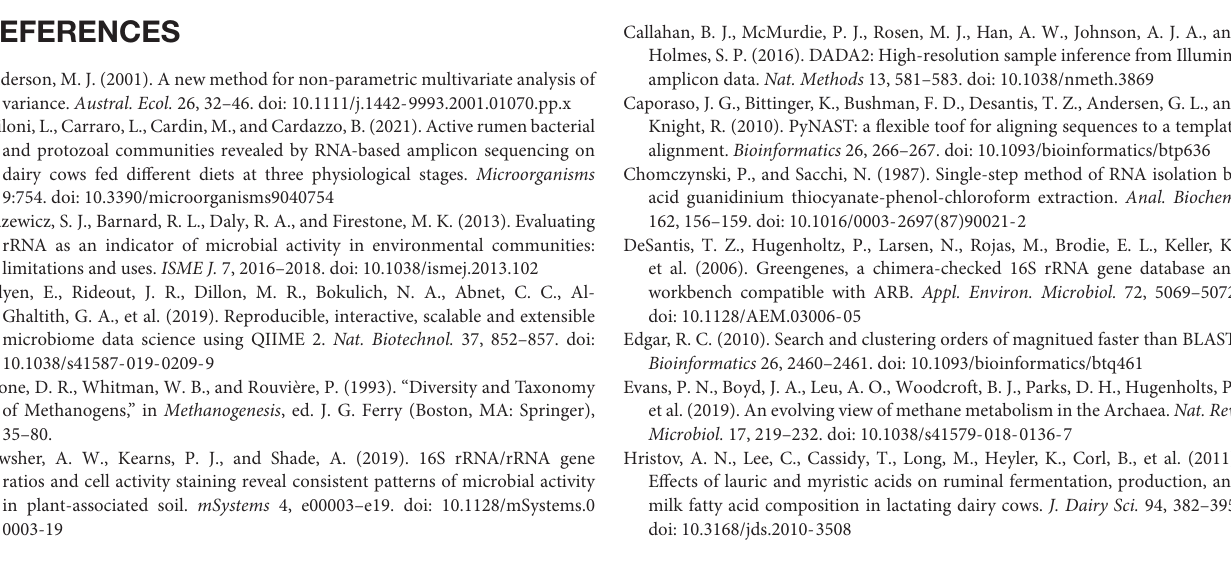
(B) tube solid (TS) samples. Microbial taxa were considered present in a sample if their sequence proportion was at least 0.01% of relative abundance. Correlation is shown by the color code (blue: positive correlation, red: negative correlation). Supplementary Table 1 | Absolute abundance of bacterial ASV (A) and archaeal OTU (B) by sample type [tube solid (TS) and cannula solid (CS)] in total (DNA) and potentially metabolically active (cDNA) communities. Supplementary Table 2 | P values denoting level of significance for community patterns revealed by principal coordinate analysis estimates by sample type. Non-parametric permutational multivariate ANOVA test was used to test differences by sampling type. Supplementary Table 3 | Mean relative abundance (%) of bacterial and archaeal taxa (identified to the genus level) by sample type [tube solid (TS) and cannula solid (CS)] in total (DNA) and potentially metabolically active (cDNA) communities. Supplementary Table 4 | Kruskal–Wallis Rank Sum Test analysis for the observed species and Shannon diversity, for Supplementary Figures 1 , 2 . Supplementary Table 5 | Differences in mean abundance of microbial taxa between total (DNA) and potentially metabolically active (cDNA) components. Significant differences in microbe composition between DNA and cDNA detected by ANCOM at a P value threshold of 0.05. Supplementary Table 6 | Concentration of volatile fatty acids (VFA) in tube solid (TS) and cannula solid (CS) samples. Supplementary Table 7A | Amplicon sequence variants (ASV) significantly associated with volatile fatty acids (VFA) in tube solid (TS) and cannula solid (CS) samples. The correlation coefficients (r) greater than 0.6 ( + ve or − ve) and P ≤ 0.01 were considered significant. Supplementary Table 7B | Selected amplicon sequence variants (ASV) ( Prevotella , Ruminococcus , and Succinivibrionaceae ) associated with volatile fatty acids (VFA) in the tube solid (TS) and cannula solid (CS) samples. The correlation coefficients (r) greater than 0.6 ( + ve or − ve) and P ≤ 0.01 were considered significant. Supplementary Table 8A | Cluster 1, connections derived using SEM (structural equations modeling). Supplementary Table 8B | Cluster 2, connections derived using SEM (structural equations modeling). Supplementary Table 8C | Cluster 3, connections derived using SEM (structural equations